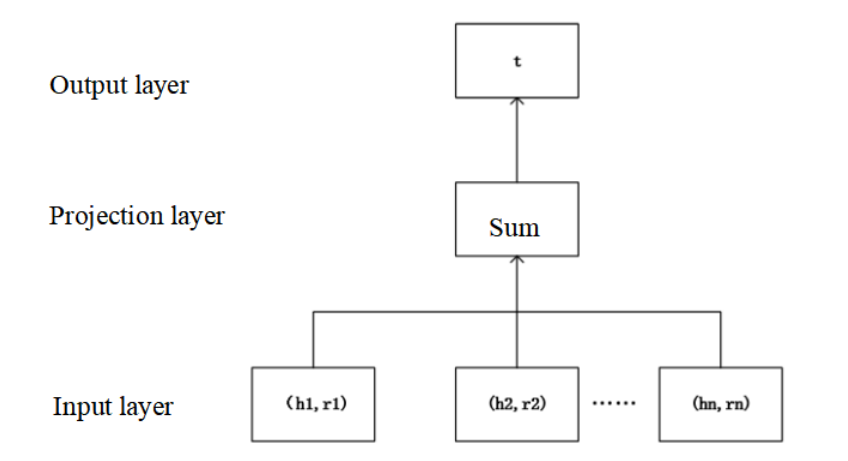
Figure 8. Neural network model structure